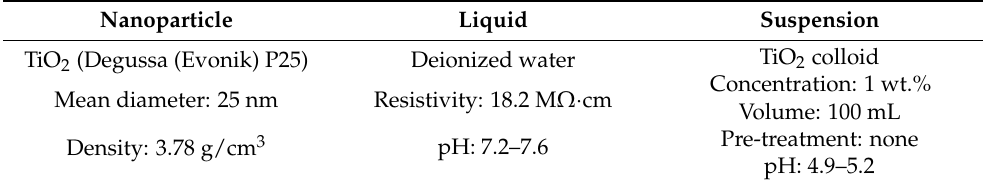
Table 4. Physical properties of the nanoparticles, solvent, and suspension used in the experiment.